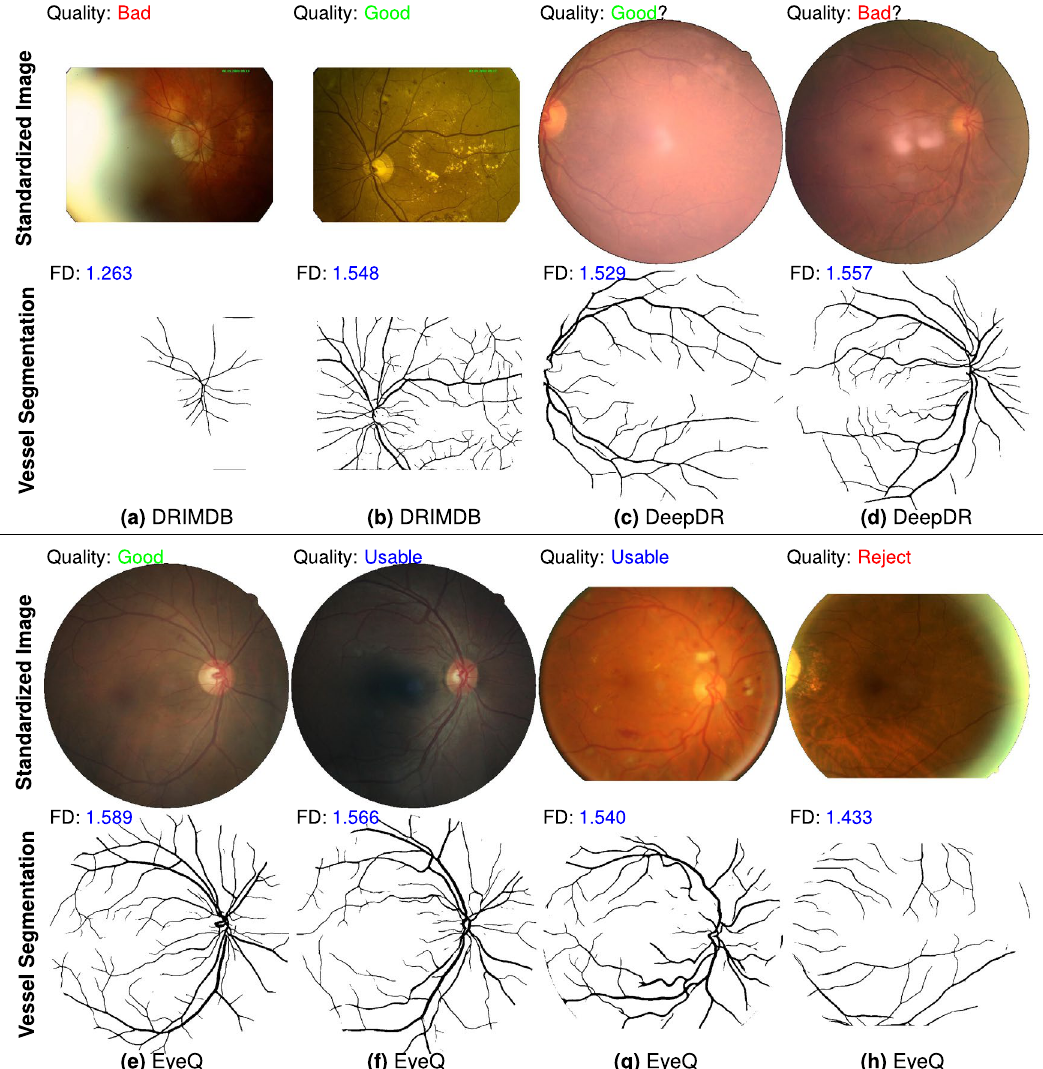
Figure 1. Qualitative comparison of proposed vascular fractal based method for automated image quality assessment. There are 8 standardized fundus images from DRIMDB, DeepDR and EyeQ datasets (image credit: ( a ) “drimdb_bad (17)”, ( b ) “drimdb_good (19)”, ( c ) “280_l1”, ( d ) “214_r2”, ( e ) “8715_right”, ( f ) “34444_right”, ( g ) “31264_left”, ( h ) “39148_left”). Quality labels given by human graders are on the top-left corner of each image. Vessel segmentation image (predicted by our segmentation model) and measured FD are displayed at the bottom of each color image. We are skeptical about the correctness of quality labels of ( c , d ). The vessel segmentation and FD results may visually support our suspect. The third row shows 4 standardized fundus images labeled as ( d ) good quality, ( e ) usable but show uneven illumination, ( f ) usable but with partial blur and ( g ) bad quality due to inadequate field definition and over-exposure. Vessel segmentation results of ( a , h ) show our model is sensitive to over-exposure issue. An image with higher quality generally has a larger